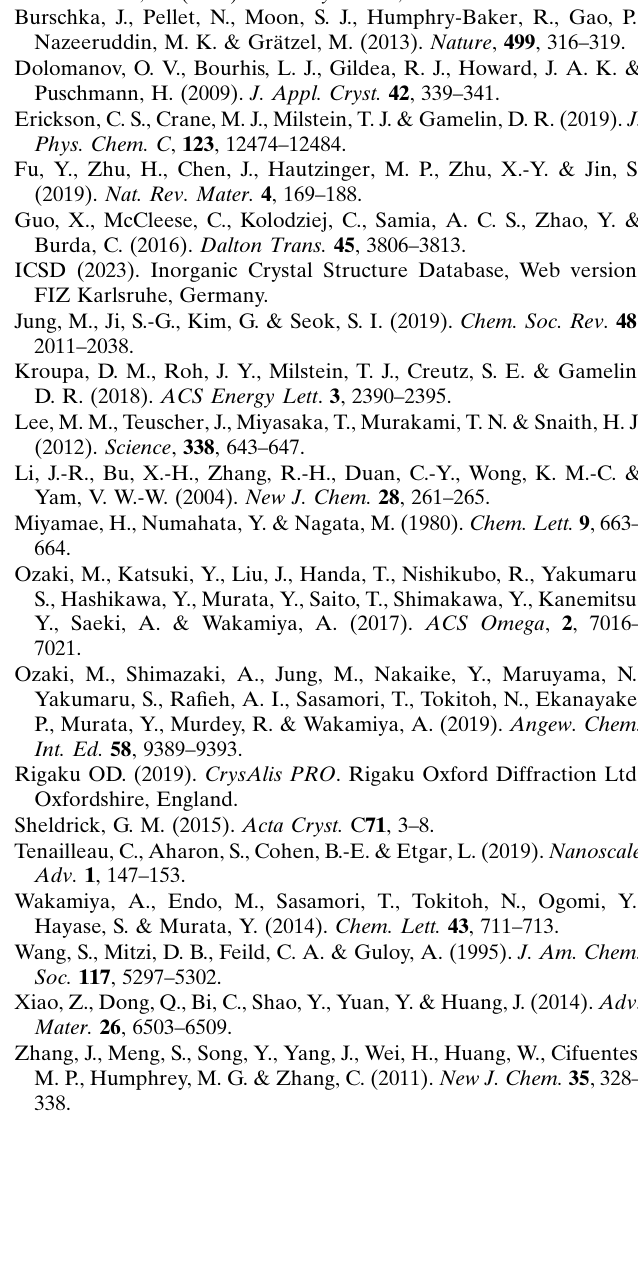
Table 1 Experimental details. Crystal data Chemical formula